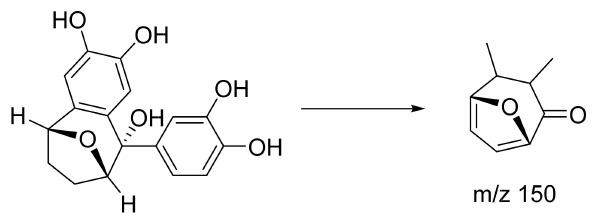
Figure 5. Proposed fragmentation pathway for sinensigenin